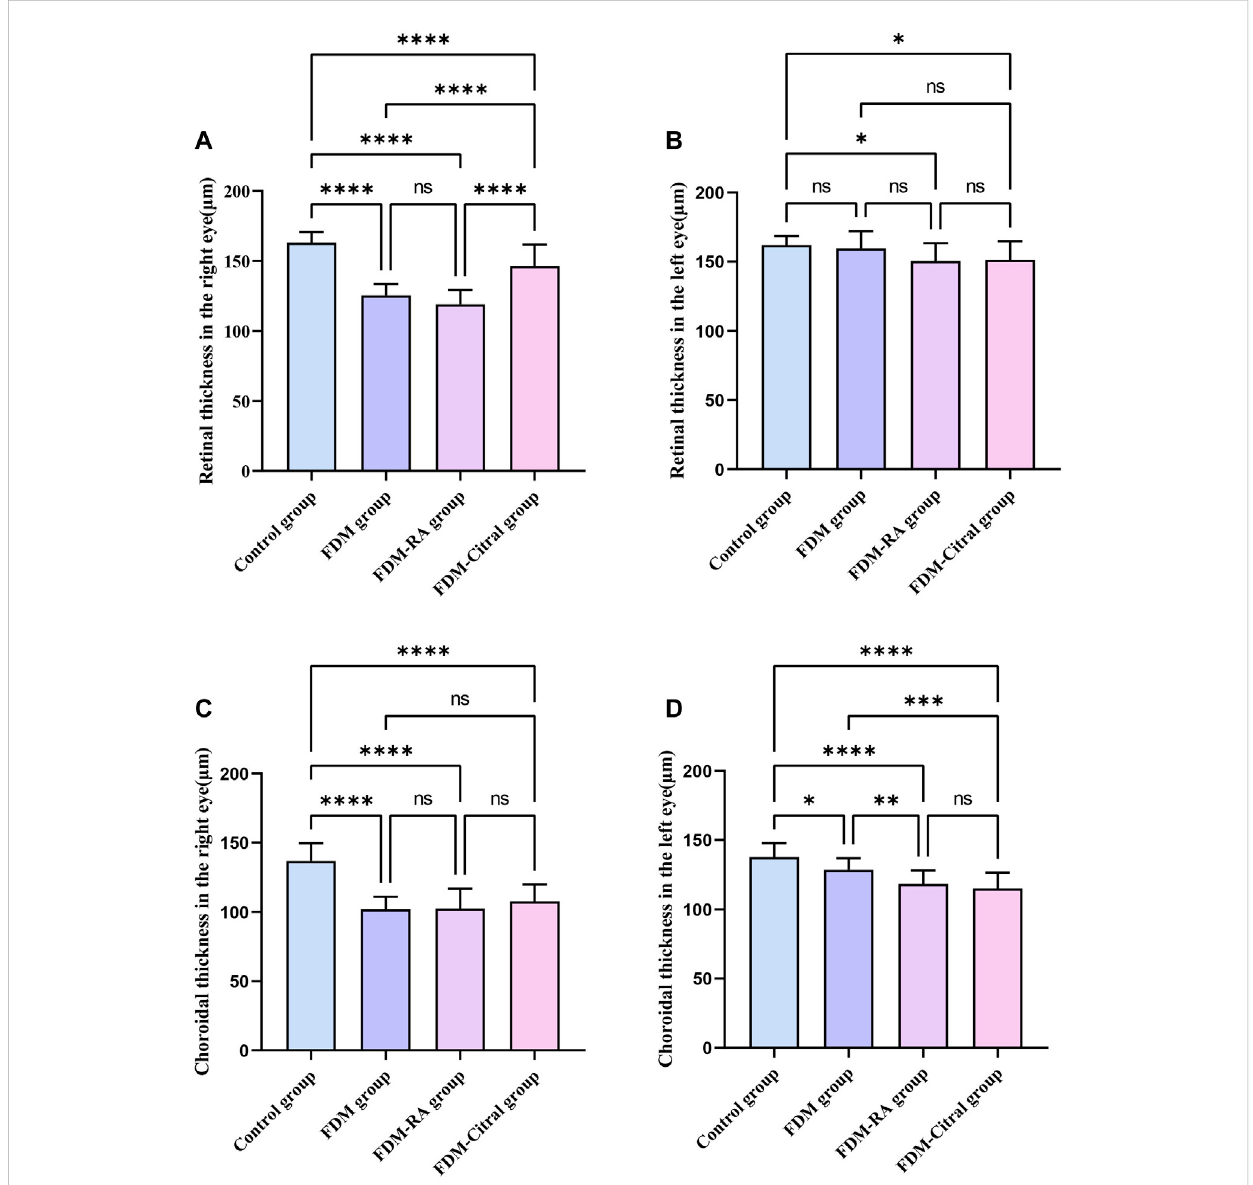
FIGURE 7 ComparativeresultsofCTandRTineachgroup( μ m).Note. (A) ,Comparison ofRTofrighteye; (B) ,ComparisonofRToflefteye; (C) ,Comparison of CT of right eye; (D) , Comparison of CT of left eye; ns means that thedifference is not statistically signi fi cant; *Indicates p ≤ 0.05; ** Indicates p ≤ 0.01; *** Indicates p ≤ 0.001; **** Indicates p ≤ 0.0001.